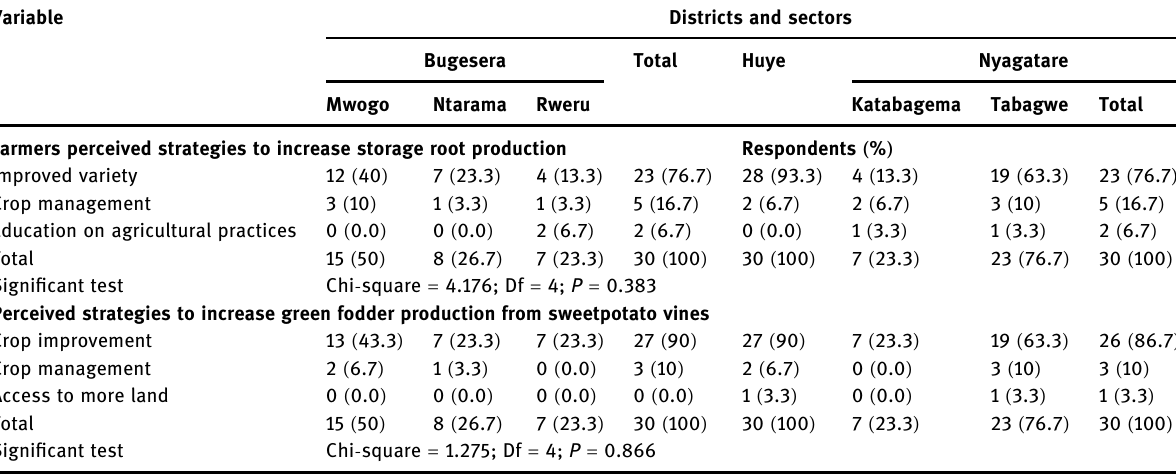
Table 3: Farmers perceived strategies to increase sweetpotato production across three selected districts of Rwanda Variable